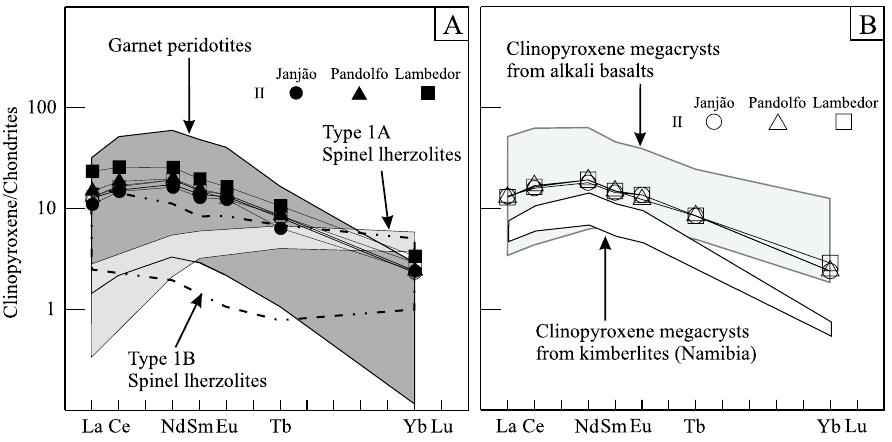
Fig. 7 – REE concentrations in clinopyroxenes from the Janjão, Pandolfo and Lambedor diatremes normalized to chondrite (Boynton 1984). A) Garnet peridotite field after Shimizu (1975), Ehremberg (1982), Ionovetal. (1993), Qietal. (1995), RodenandShimizu(2000), SchmidbergerandFrancis(2001) and Grégoire et al. (2003); Type 1A and 1B spinel peridotite fields after Kempton (1987). Megacrysts from Namibia field after Davies et al. (2001). B) Field of clinopyroxenes from alkali basaltic-like magmas (cf. Fig. 2B) after Irving and Frey (1984), Liotard et al. (1988), Dobosi and Jenner (1999), Shaw and Eyzaguirre (2000), Rankenburg et al. (2004) and Akinin et al.